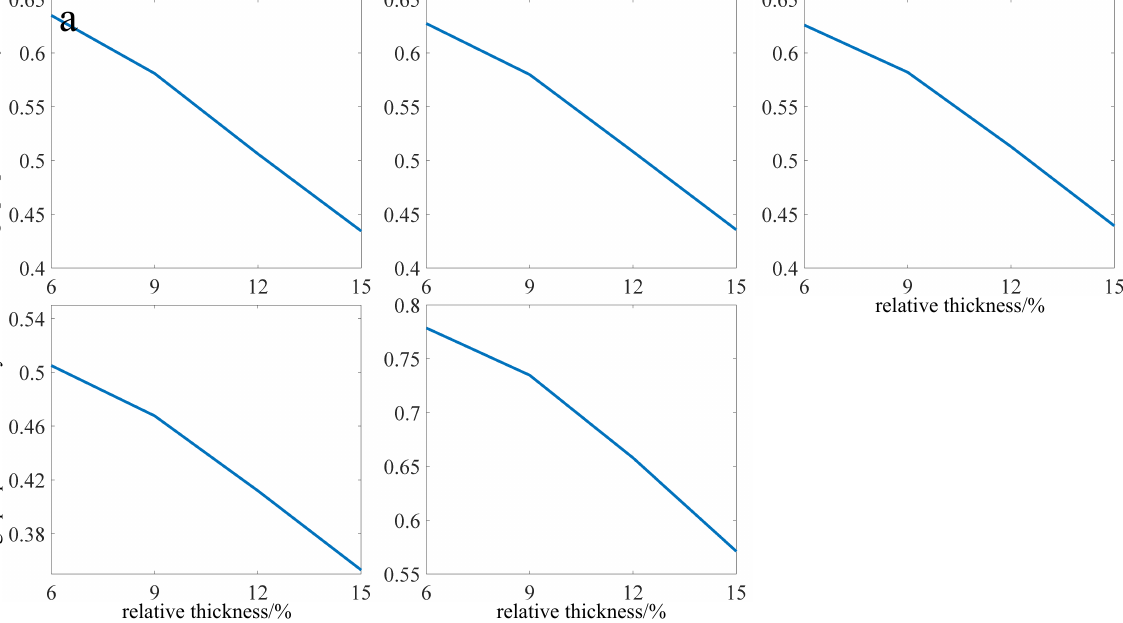
Figure 7. Variation in the average propulsion velocity with the airfoil: ( a ) first type, ( b ) second type, ( c ) third type, ( d ) fourth type, and ( e ) fifth